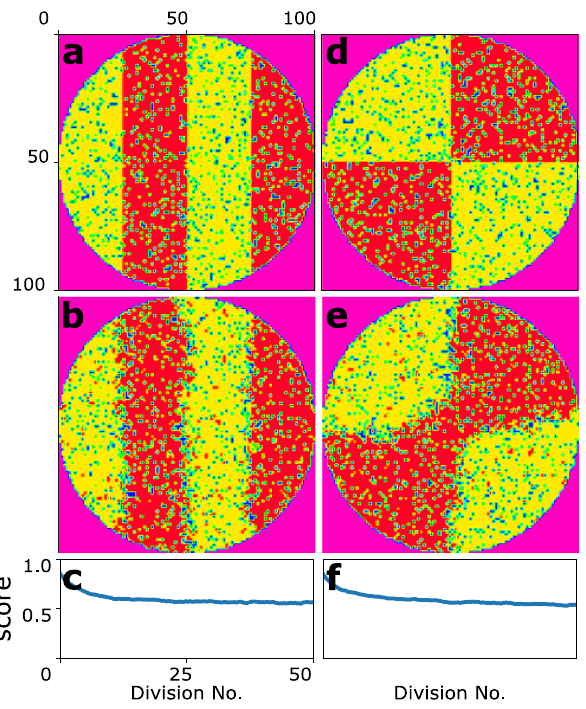
Figure 6. The system behaviour in the face of more complex initial spatial patterns. ( a , d ) The initial state of the system. ( b , e ) The final states of the system. ( c , f ) The corresponding score